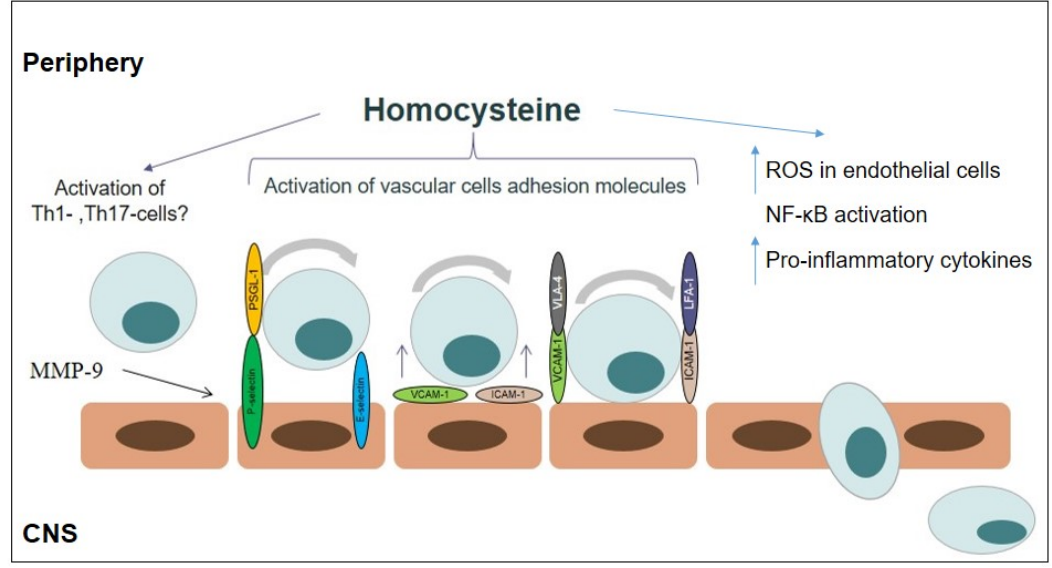
Figure 2. The possible mechanism action of homocysteine in multiple sclerosis pathogenesis: (i) oxidative stress; (ii) inflammation (upregulation of adhesion molecule expression, T-cell activation, inducing pro-inflammatory cytokine production).